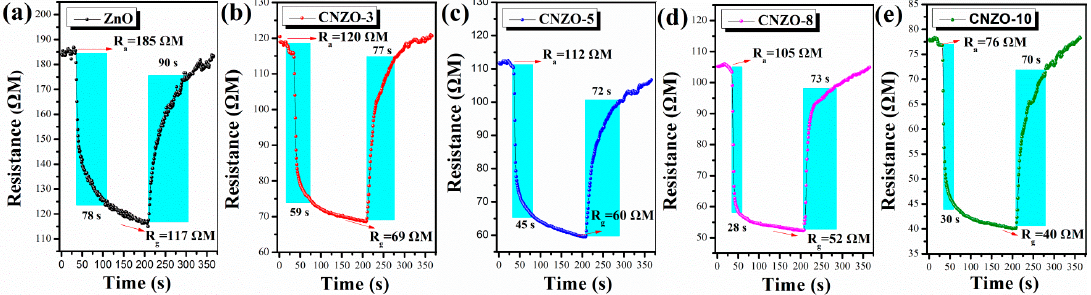
Figure 8. UV-light activated response resistance ( a – e ) curves of the sensors to 2000 ppm CH 4 at room temperature.